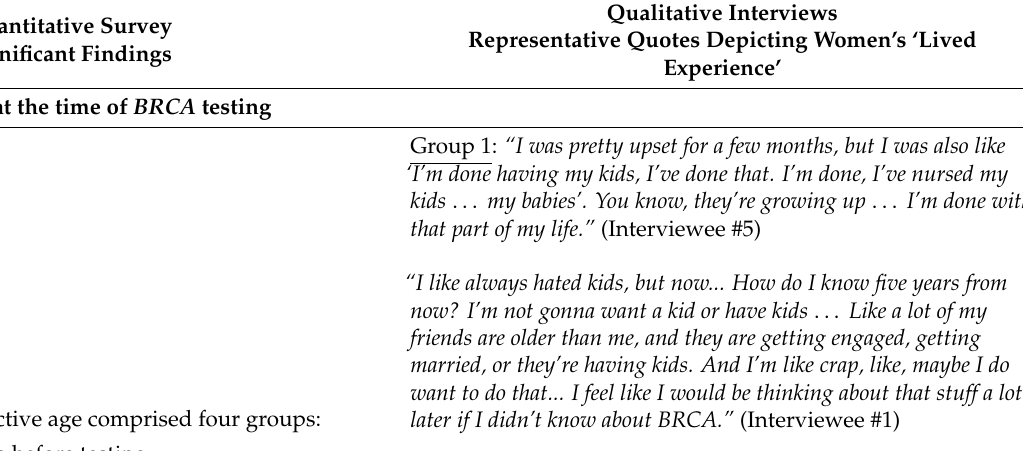
Table 4. Integration of quantitative and qualitative